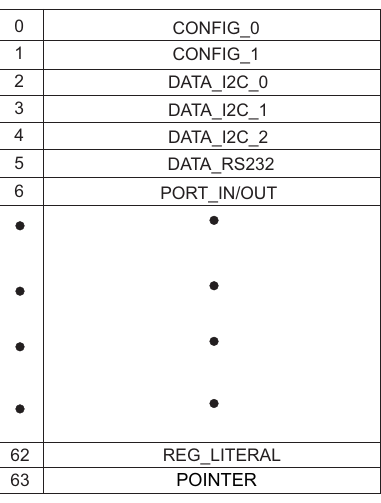
Figure 21. Register bank implemented for the PAMPIUM IC.